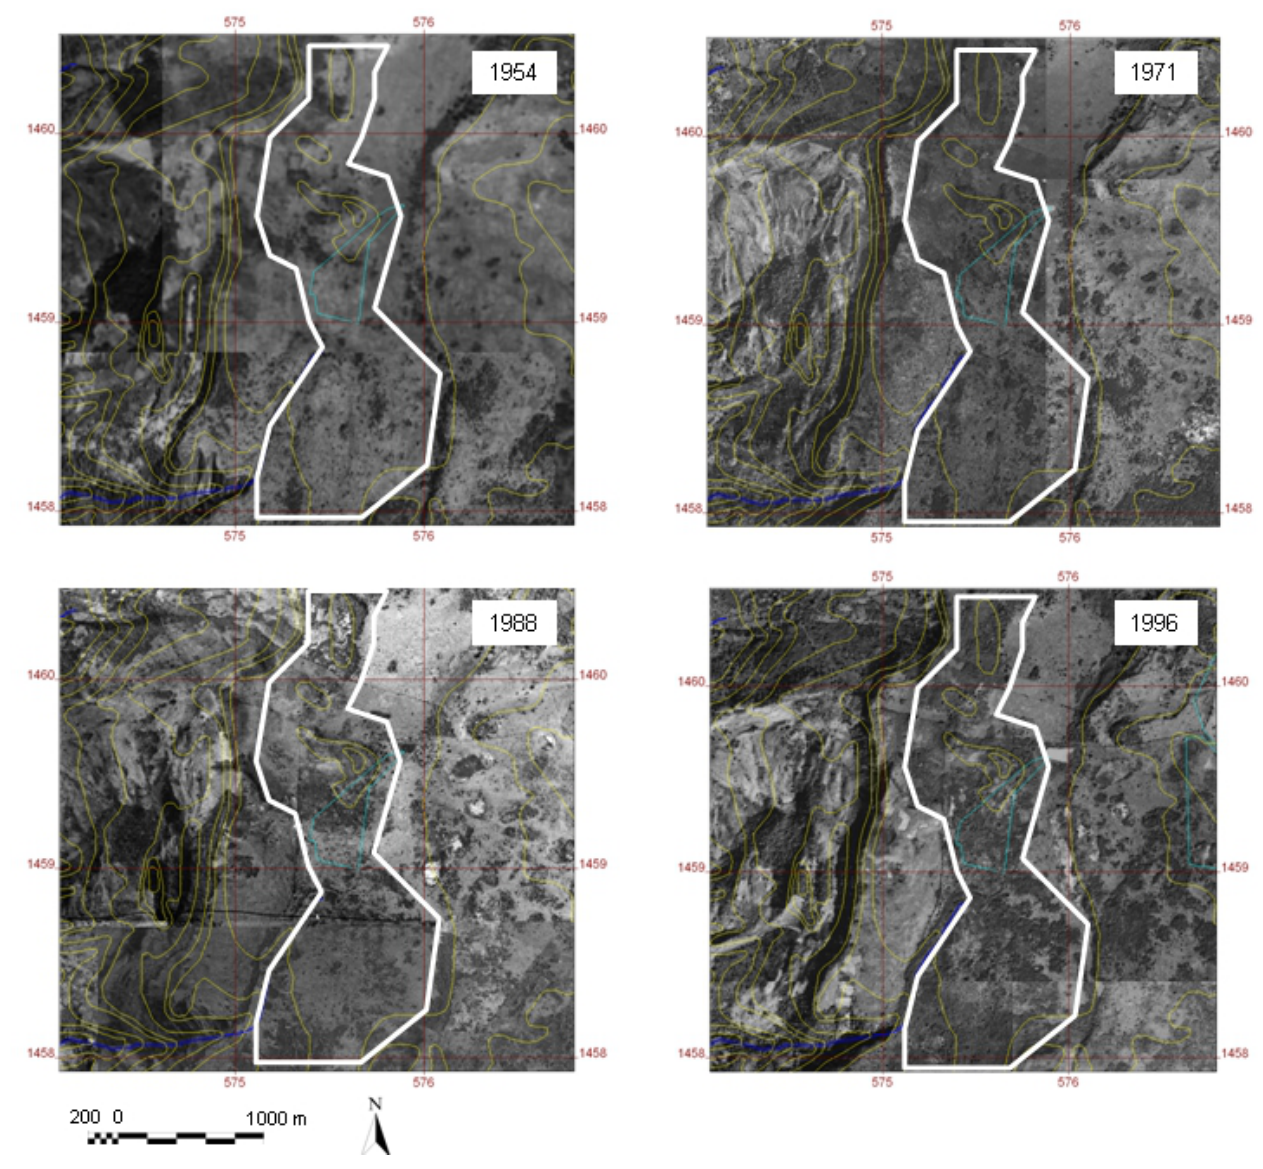
Fig. 4. Bush encroachment trends (1954, 1971, 1988, and 1996) in the study area (the area within the white line highlights the changes in shrub